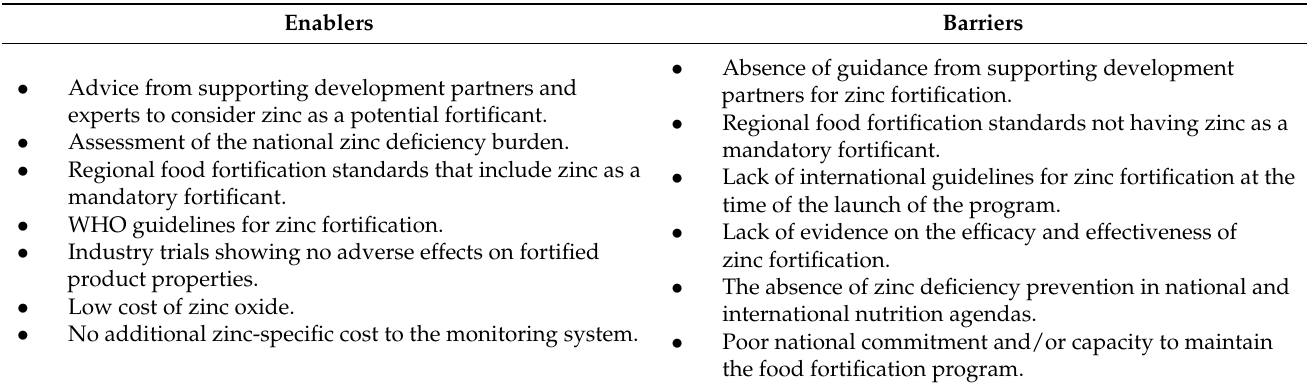
Table 2. Summary of enablers and barriers to mandatory zinc food